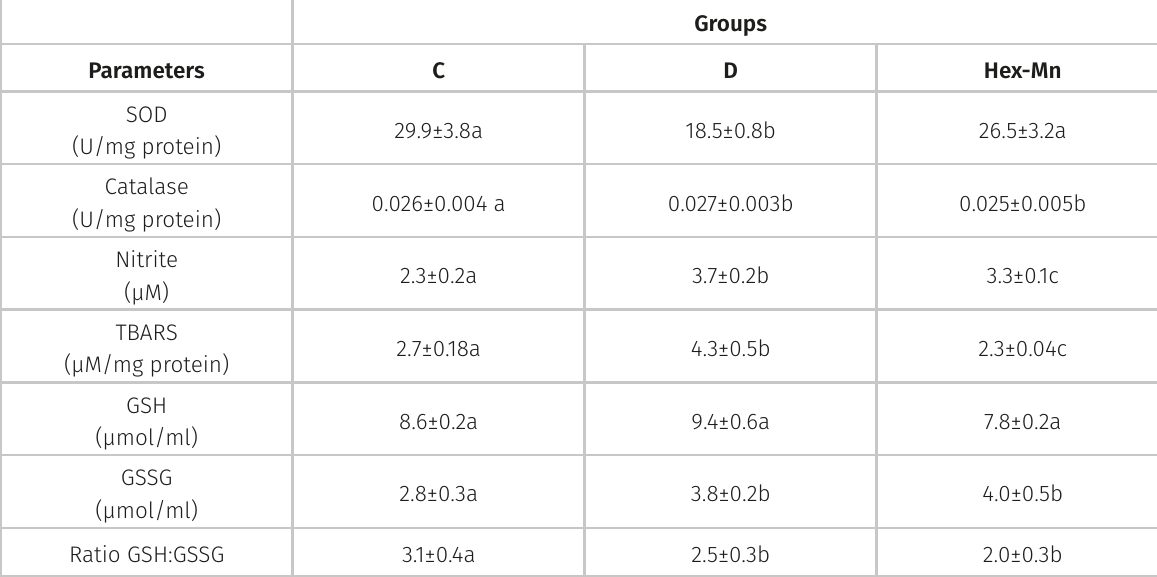
Table V. Effects of Hex-Mn and Chlor-Mn on SOD, catalase, nitrite, TBARS, GSH and GSSH in the liver in control and diabetic treated for 21 days.